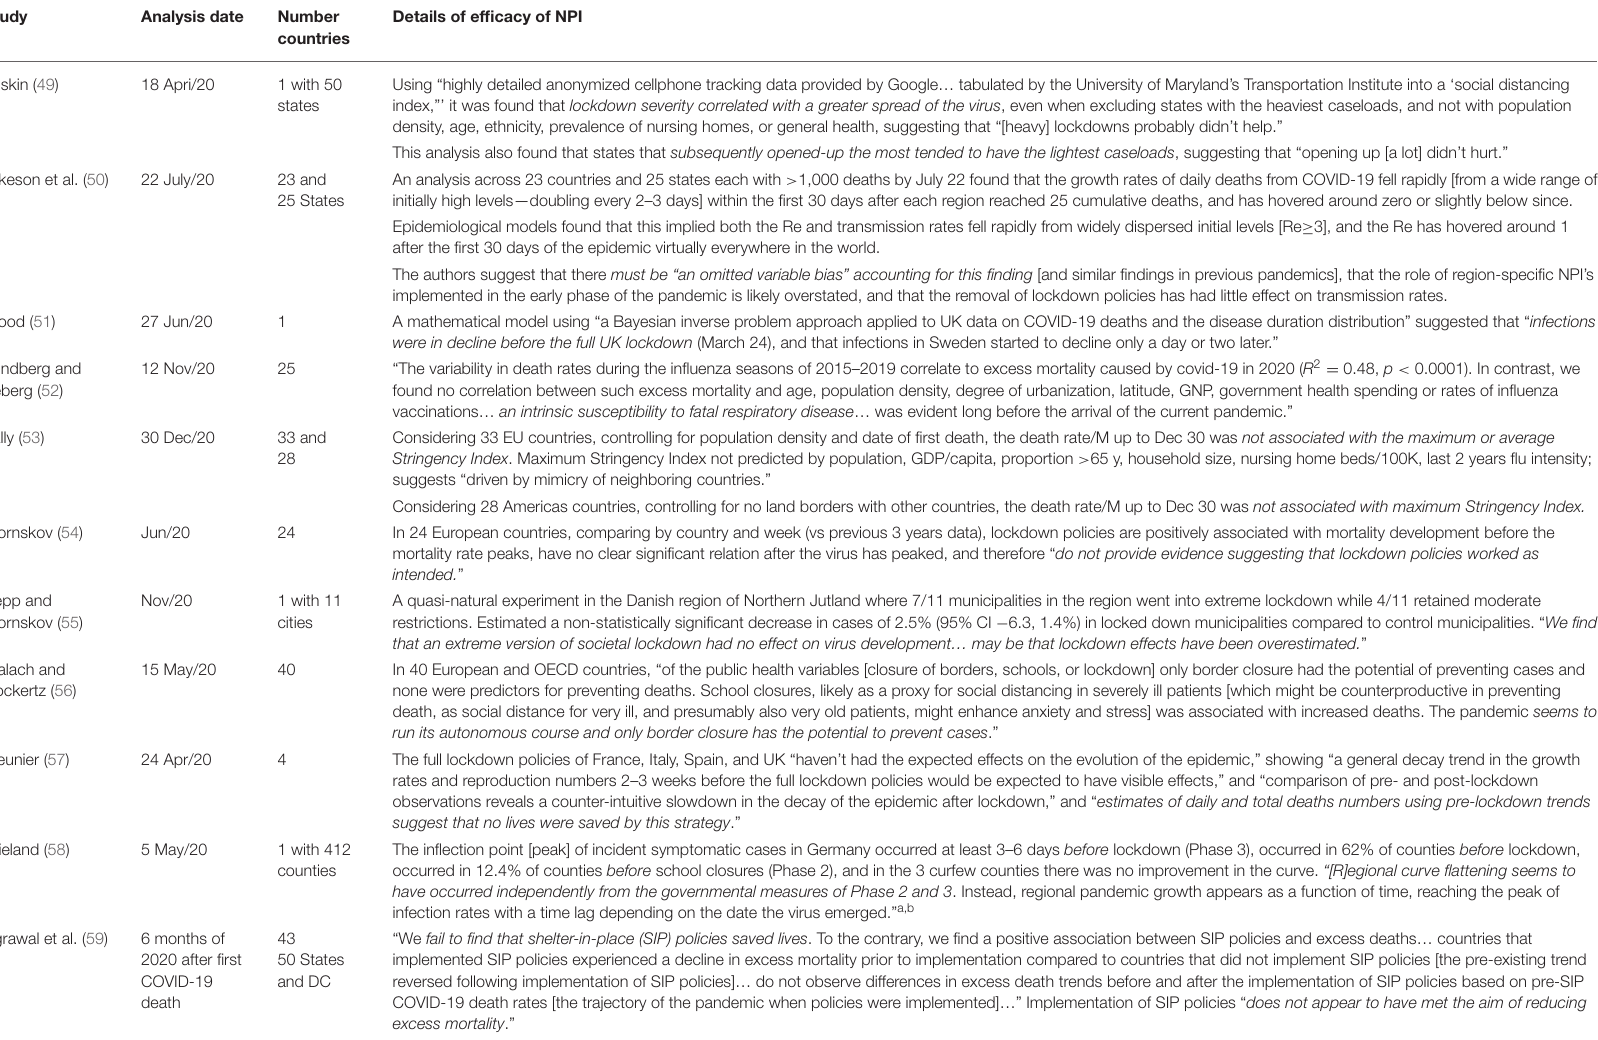
TABLE 4 | Studies published as preprints suggesting that efficacy of nonpharmaceutical interventions (lockdowns) to prevent spread of COVID-19 are at best highly exaggerated. Study Number